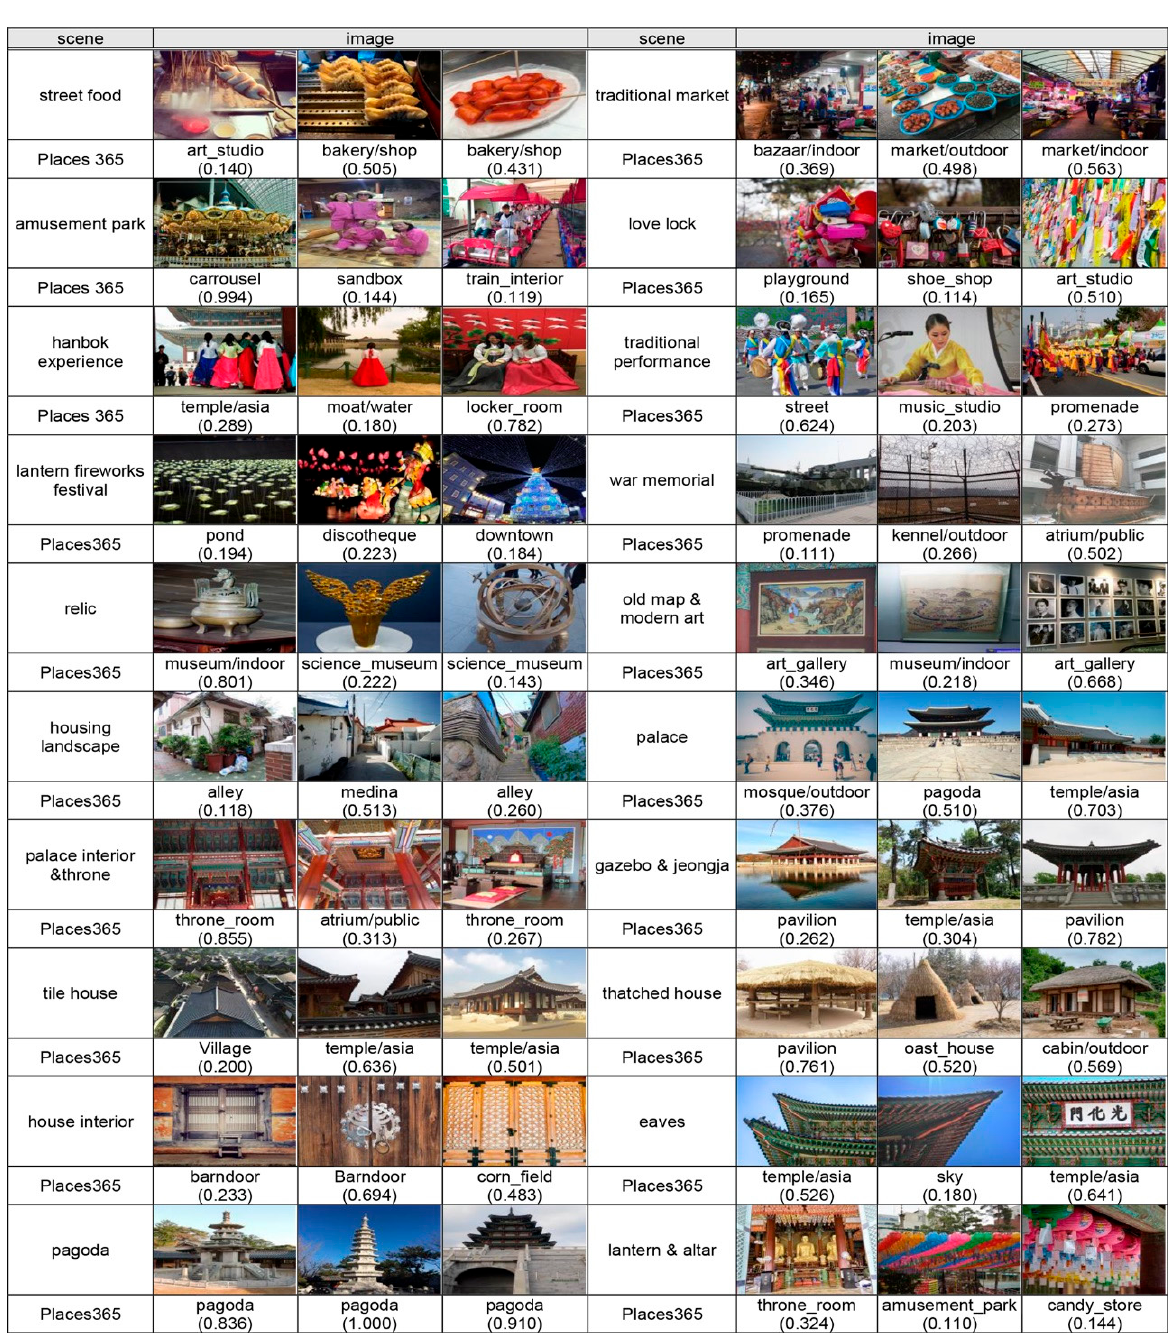
Figure 16. Classification results based on Places365 for scenes reflecting Korean